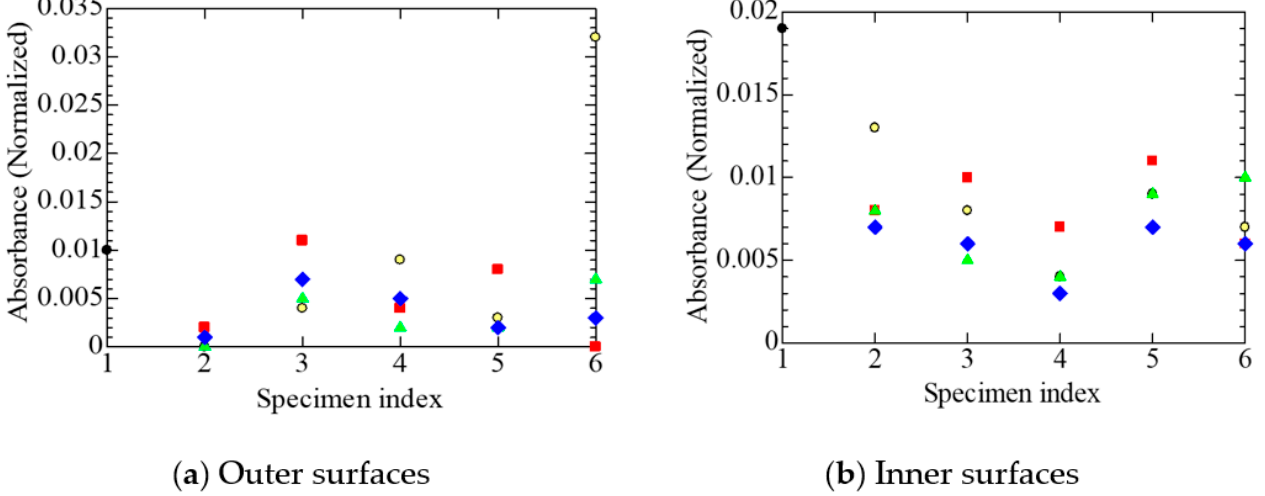
Figure 4. Normalized absorbance due to acid carbonyl, measured at each stage on various tubular specimens. The numeric letters on the abscissa represent the sample statuses; 1: new and unaged, 2: as removed from the NPP or aged equivalently, 3: after the radiation R L , 4: after the simulated LOCA, 5: after the radiation R S , 6: after the simulated SA. Refer also to Table 2. Refer to Table 1 for sample symbols. Several data may overlap each other.